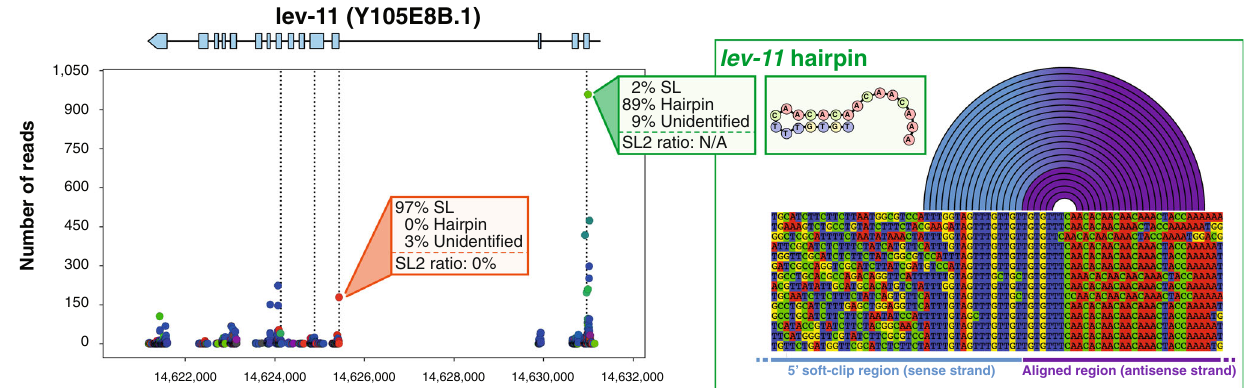
36 displayed a single SL1 trans -spliced site. M60.4 presents two trans -splicing sites indicative of two alternative promoters with distinct SL1/2 ratios. The Y37E3.7/Y37E3.8 operon with typical SL1 and SL2 preference. lev-11 gene distal promoter carries an endogenous hairpin while the proximal promoter is mainly